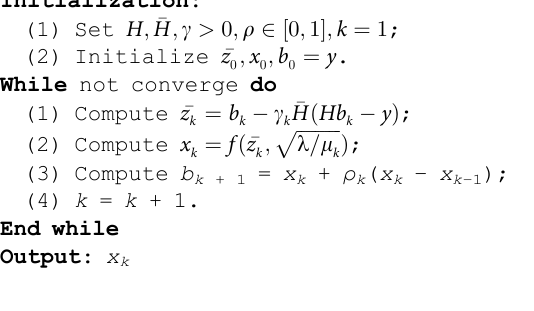
Algorithm 2 Three-step iterative